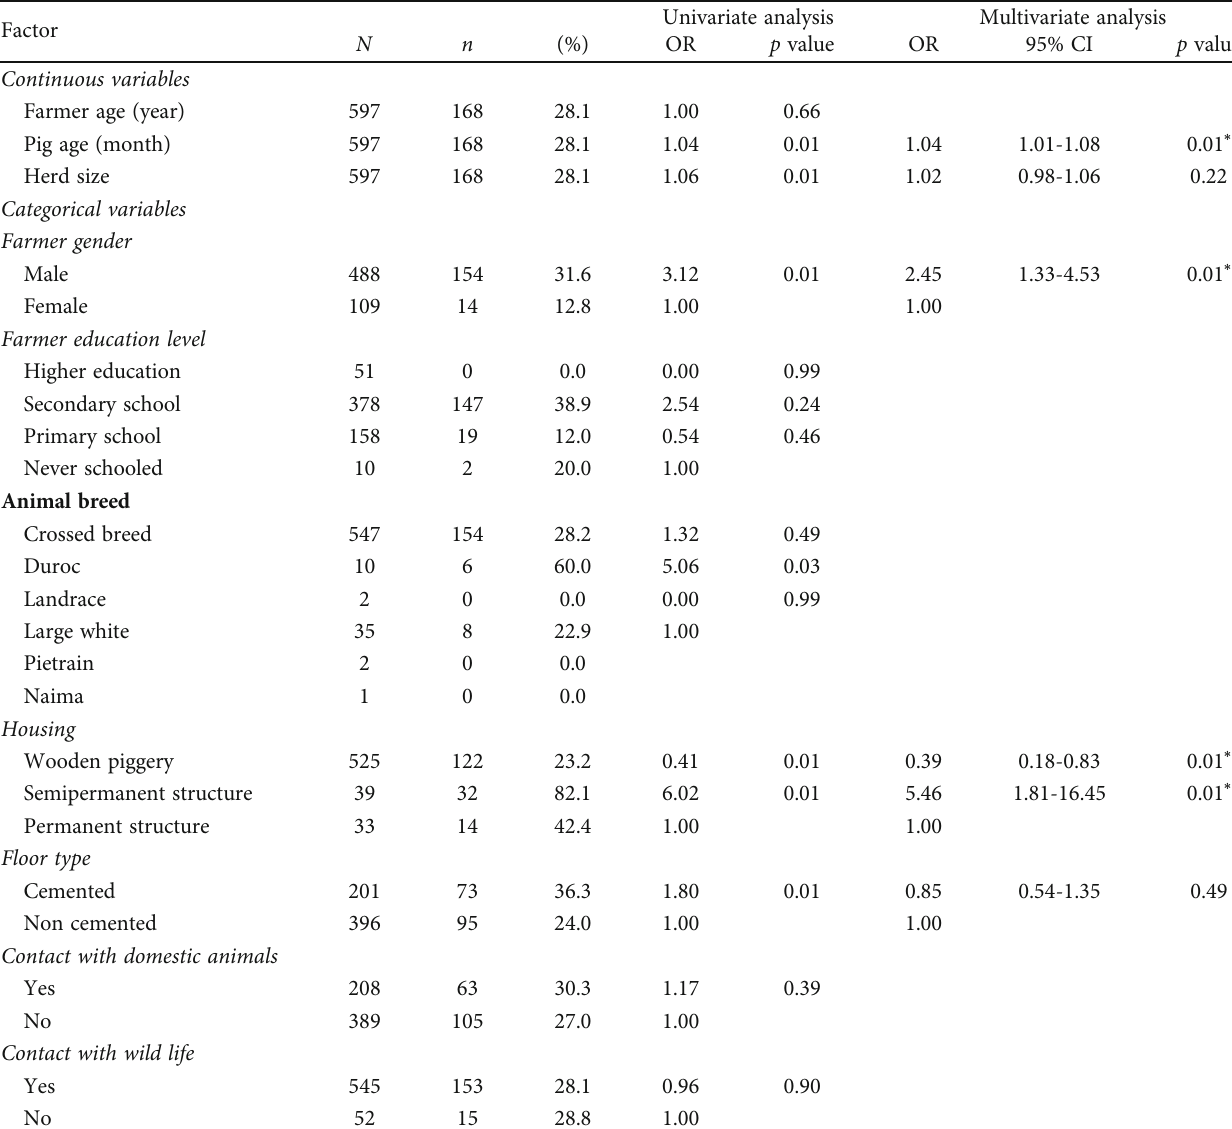
Table 5: Logistic regression analysis of risk factors for Trichostrongylus sp. infection in pig farms in Menoua Division. Results are expressed in terms of odd ratio (OR) and 95% con fi dence interval